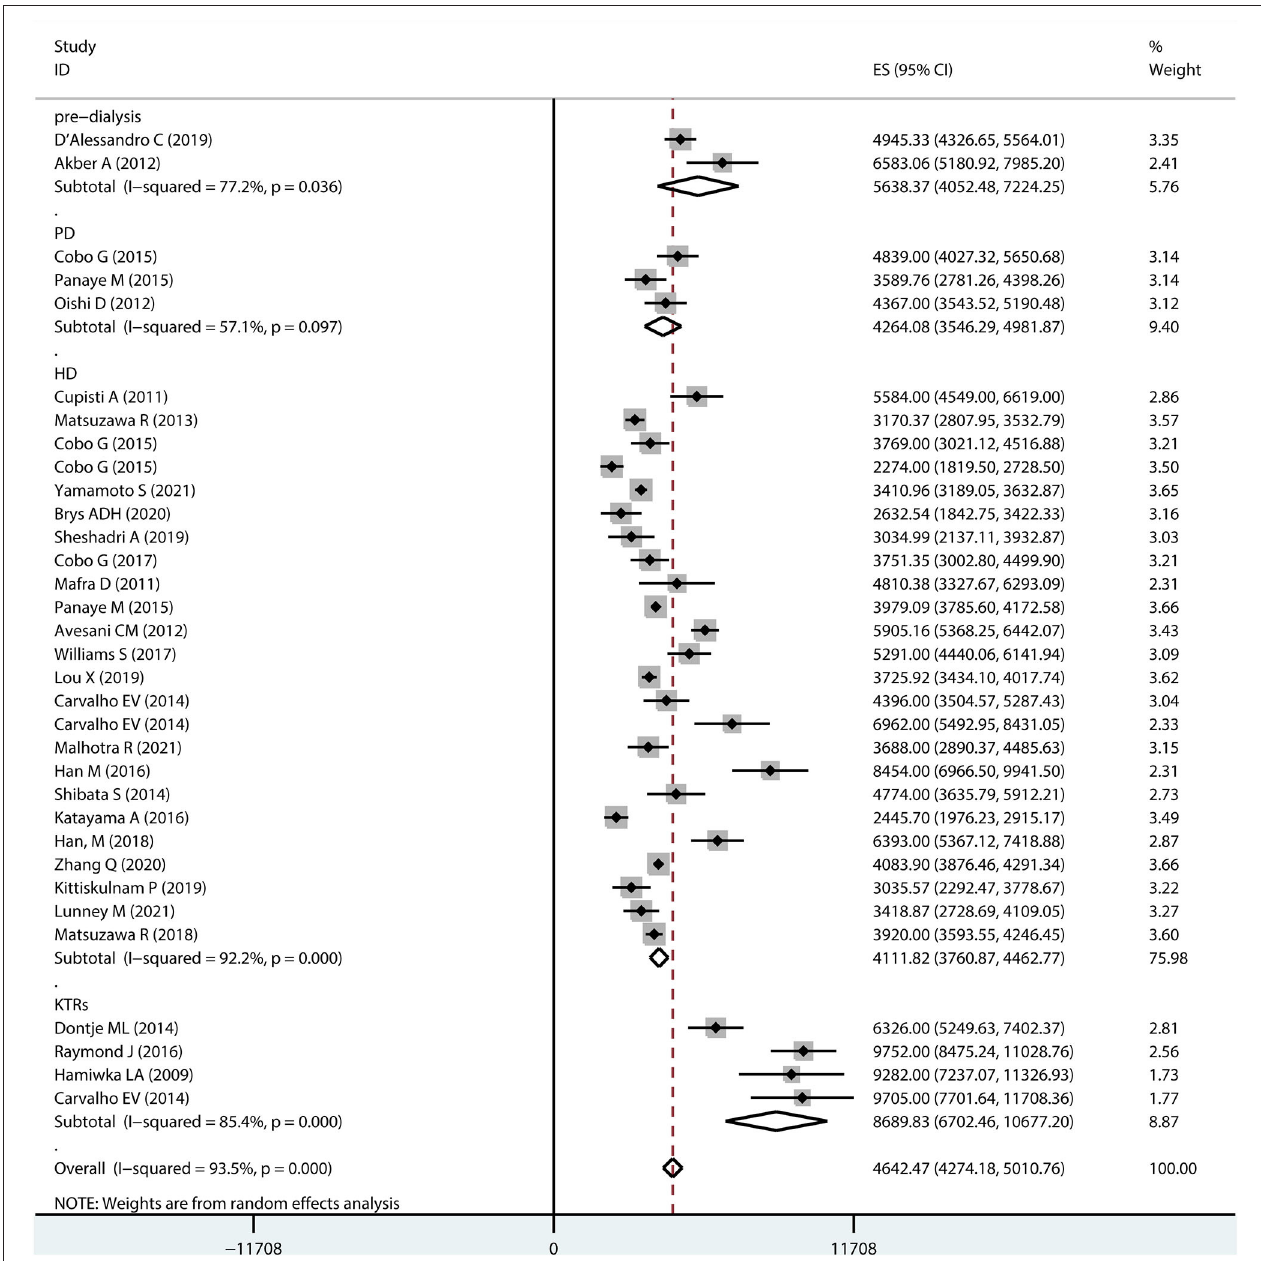
FIGURE 2 | Forest plot of the overall step